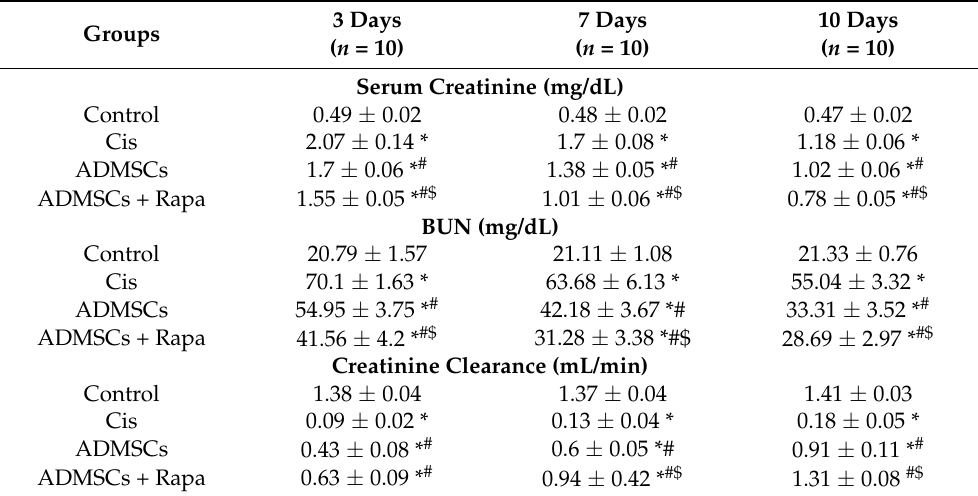
Table 2. Effects of MSCs pretreated with rapamycin on kidney functions (serum creatinine and BUN) at 3, 7 and 10 days after cisplatin